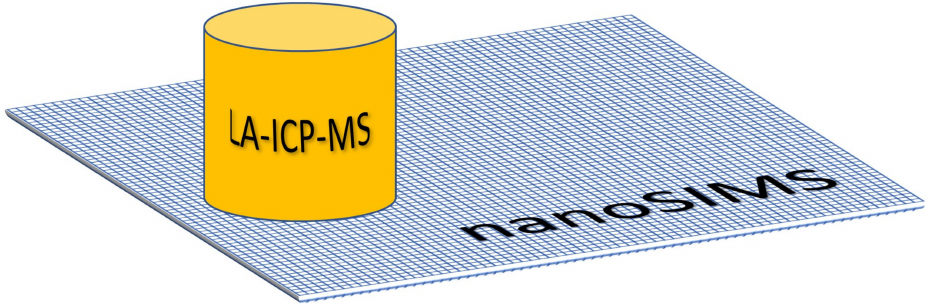
Figure 15. The equal-volume representations of a 15 µ m single time-resolved LA-ICP-MS crater and a nanoSIMS 50x50x1 µ m mapped area. Scales and analysis volumes are